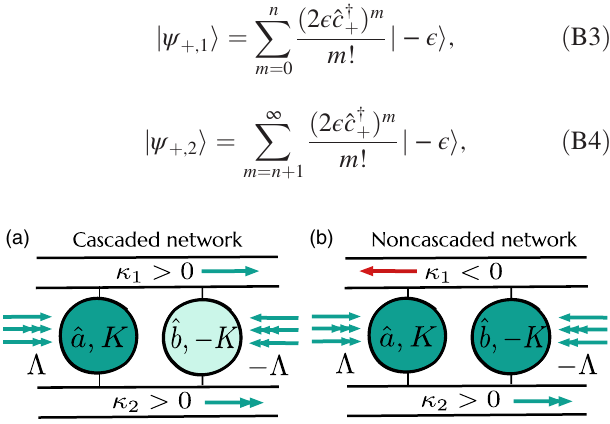
FIG. 9. Realizing quantum bistability by breaking chirality. (a) Typical cascaded network corresponding to CQA solution of the Kerr resonator problem. In this cascaded scheme, the the generalized bistable points of the Kerr resonator (cf. Fig. 3) are only achievable in the limit of vanishing loss. These generalized bistable points are exactly realizable by using a two cavity setup (b) which is not cascaded, i.e., where the chirality of one of the waveguides is